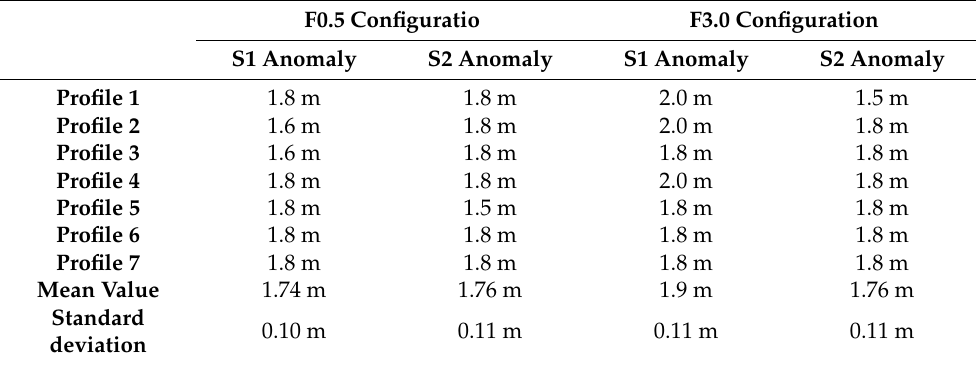
Table 1. Estimated depths along the profiles acquired with F0.5 and F3.0 configuration.